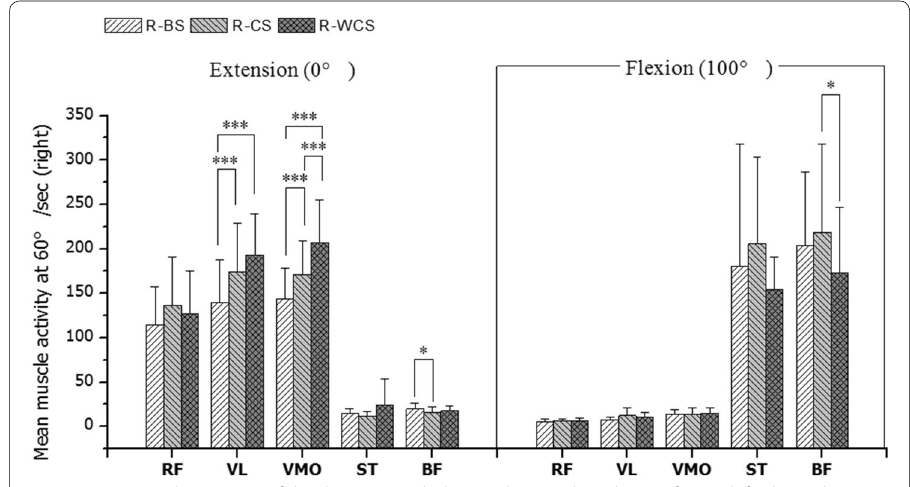
Fig. 4 Mean muscle activities of the dominant right legs at the angular velocity of 60°/s: left (during knee extension); right (during knee flexion)